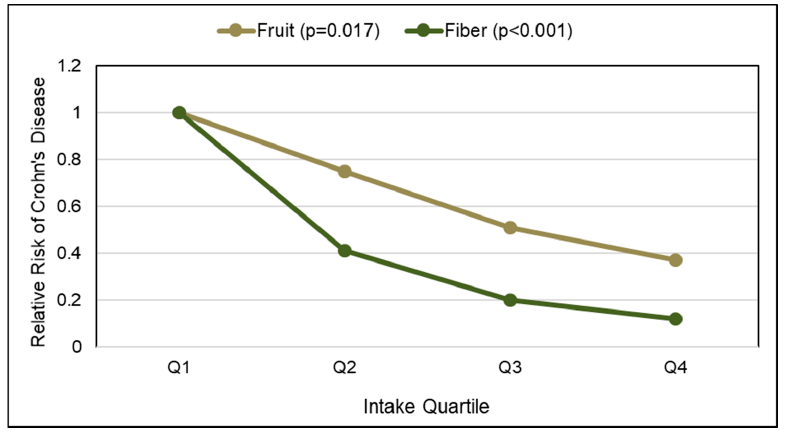
Figure 3. Risks of Crohn’s disease in children for fruit and total fiber intake [82].